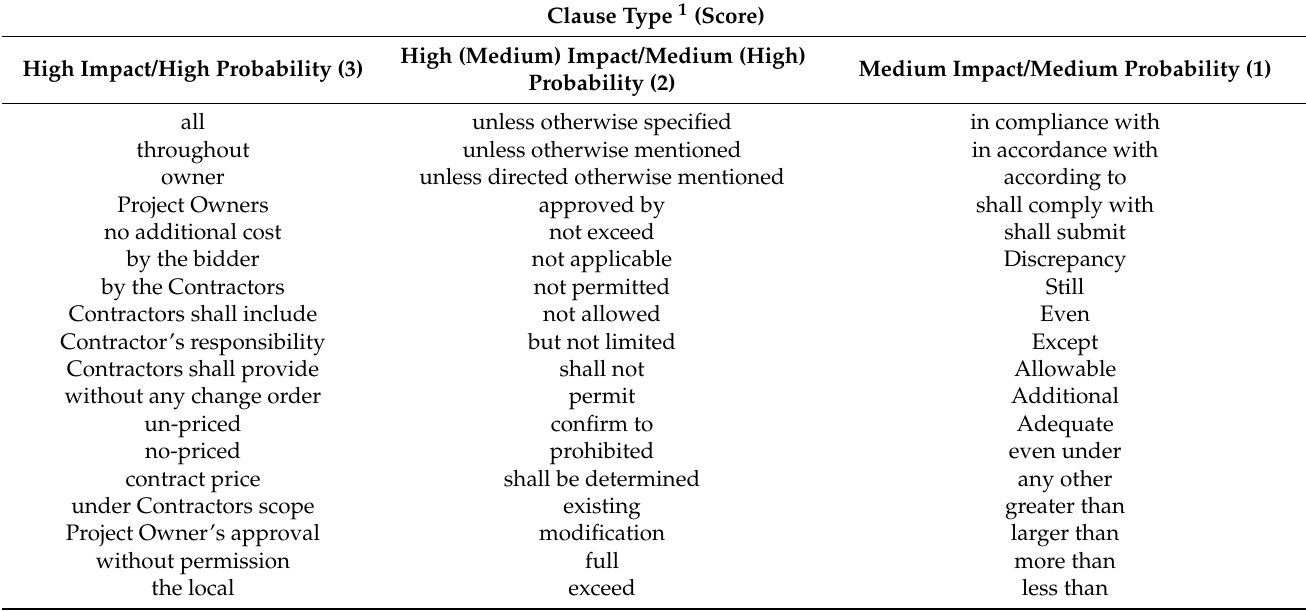
Table 1. Technical risk lexicon (example).